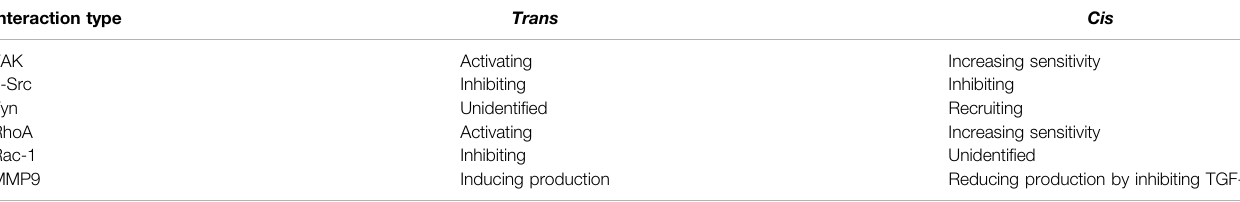
TABLE 1 | The interaction of Thy-1 with integrins in trans - or in cis -results in diverged impacts on downstream integrin signaling. Interaction